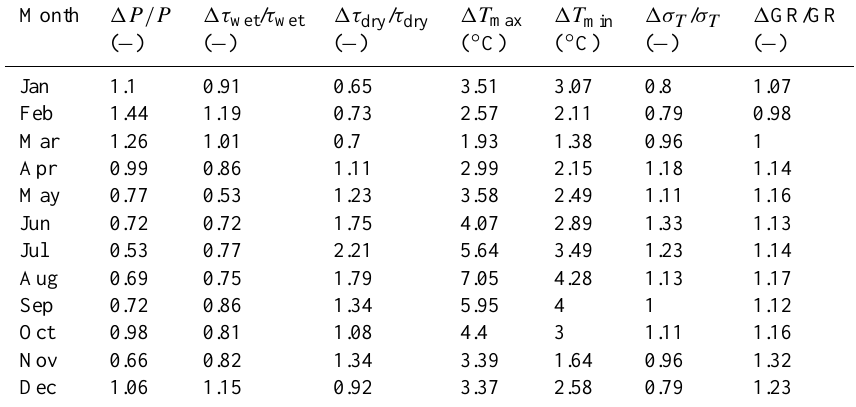
Table 3. Changes ( 1) in monthly climate statistics between 2071–2100 and 1961–1990 (reference) simulated by the Climate High Resolution Model for the Swiss Plateau under the assumption of an A2 emissions scenario. Changes in mean precipitation rate ( P ), duration of wet ( τ wet ) and dry ( τ dry ) spells, global radiation (GR) and inter-annual standard deviation of air temperature ( σ T ) are relative; changes in daily maximum ( T max ) and minimum ( T min ) air temperature are